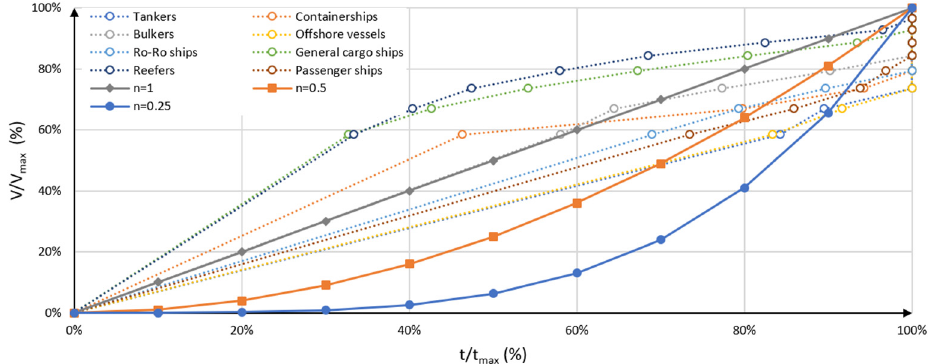
Figure 4. Comparison of generic and actual speed profiles for coastal ships.